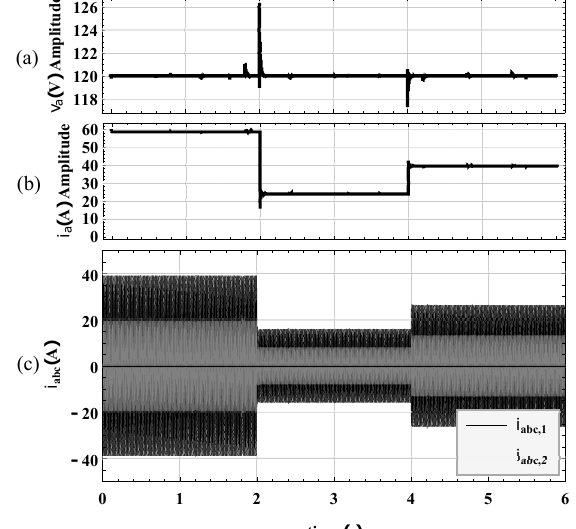
Figure 22. Load phase a, ( a ) voltage and ( b ) overall current amplitudes. ( c ) three-phase ac currents sharing between DGU 1 and DGU 2